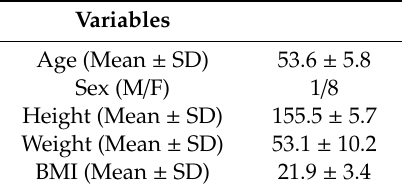
Table 1. Baseline characteristics.